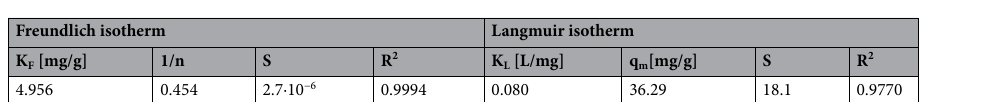
Table 1. The calculated values derived from Freundlich and Langmuir isotherm models.